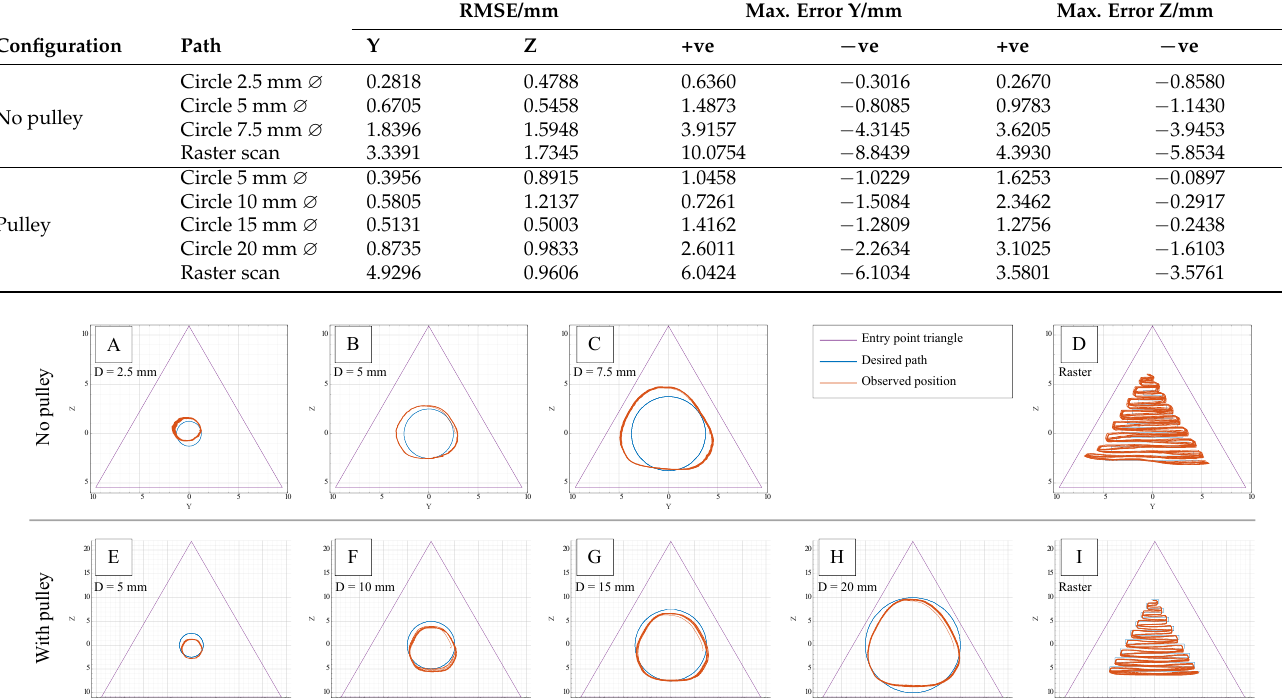
Table 3. Summary table for results of each of the two-DOF tests.